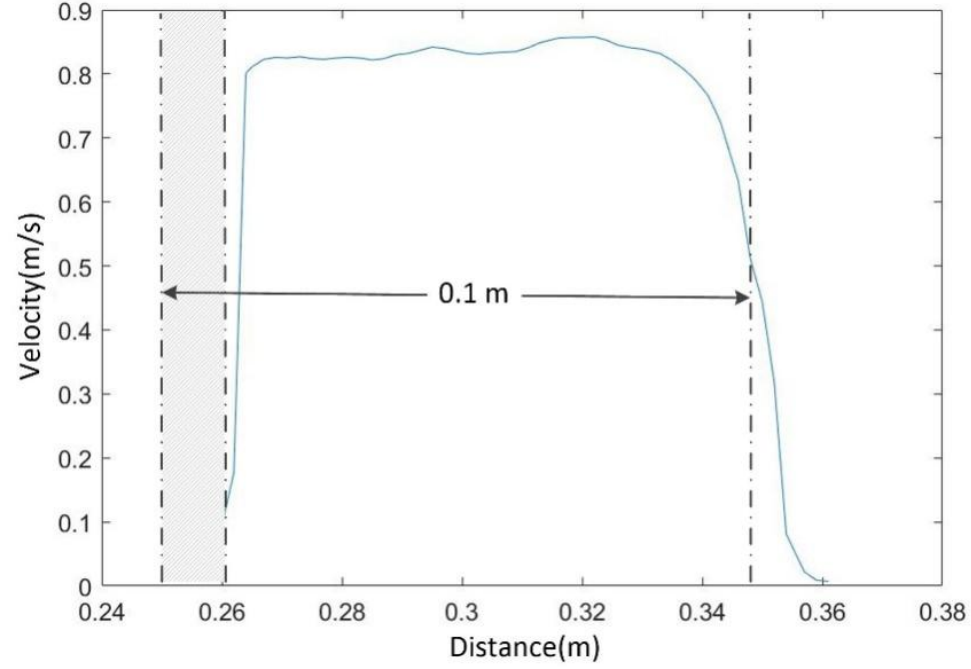
Figure 11. Cross-section velocity distribution averaged with a total of 40 calibrated velocity fields.